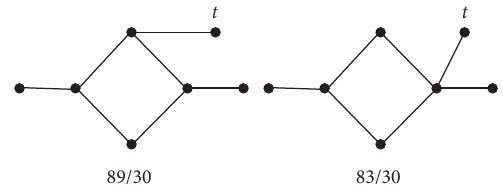
Figure 6: The graphs related to Case 1 of Theorems 3 and